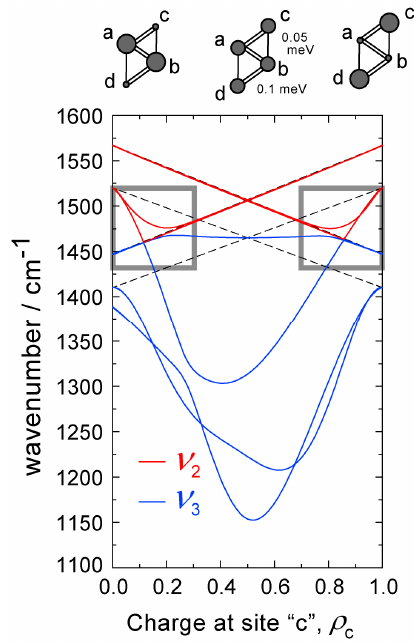
Figure 5. Behavior of the ν modes in a non-linear tetramer ( M : H = 4:2) as a function of 3 the fractional charge, ρ . The frequencies of the ν modes are also shown in this figure. 2 Transfer integrals are shown at the top of the panel. On-site and nearest neighbor Coulomb energies are assumed to be 0.8 and 0.33 eV, respectively. Avoided crossing is assumed in this calculation. Avoided crossing is expected to occur for both large ρ and small ρ . The c c areas of avoided crossing are enclosed by the